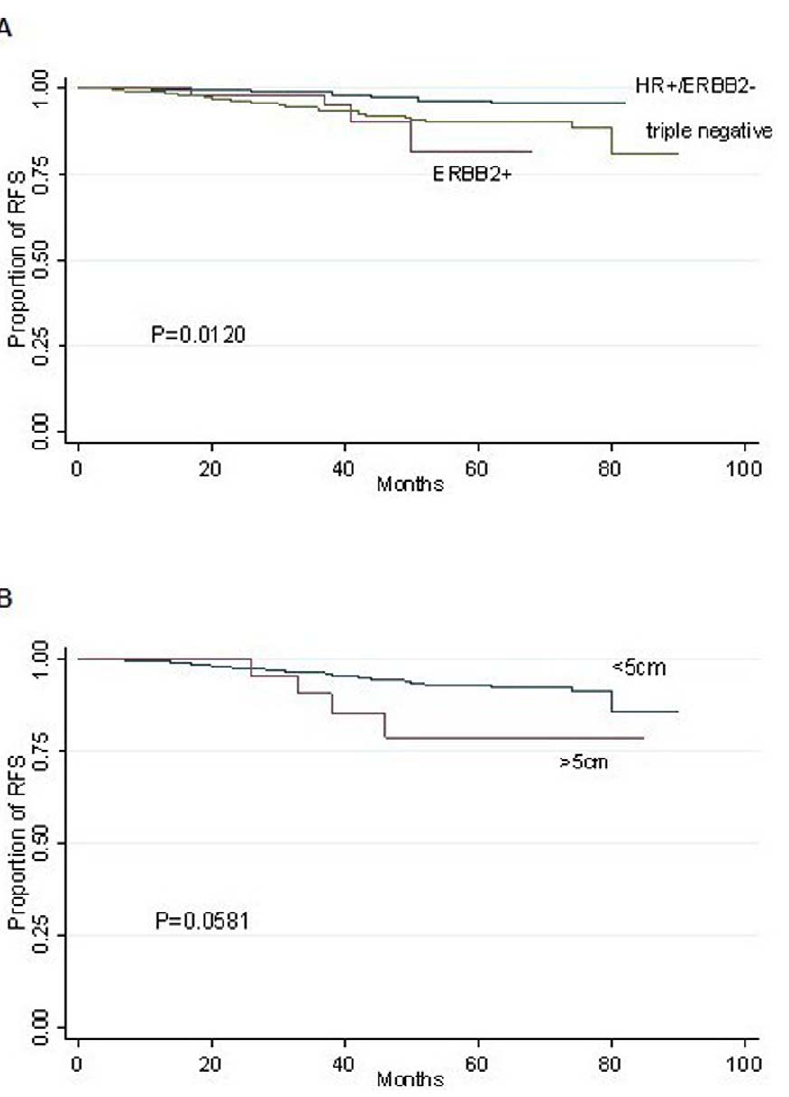
Figure 2. Kaplan–Meier curves for RFS in 883 ALN negative breast cancer patients by HR/ERBB2(A) and tumor size (B).